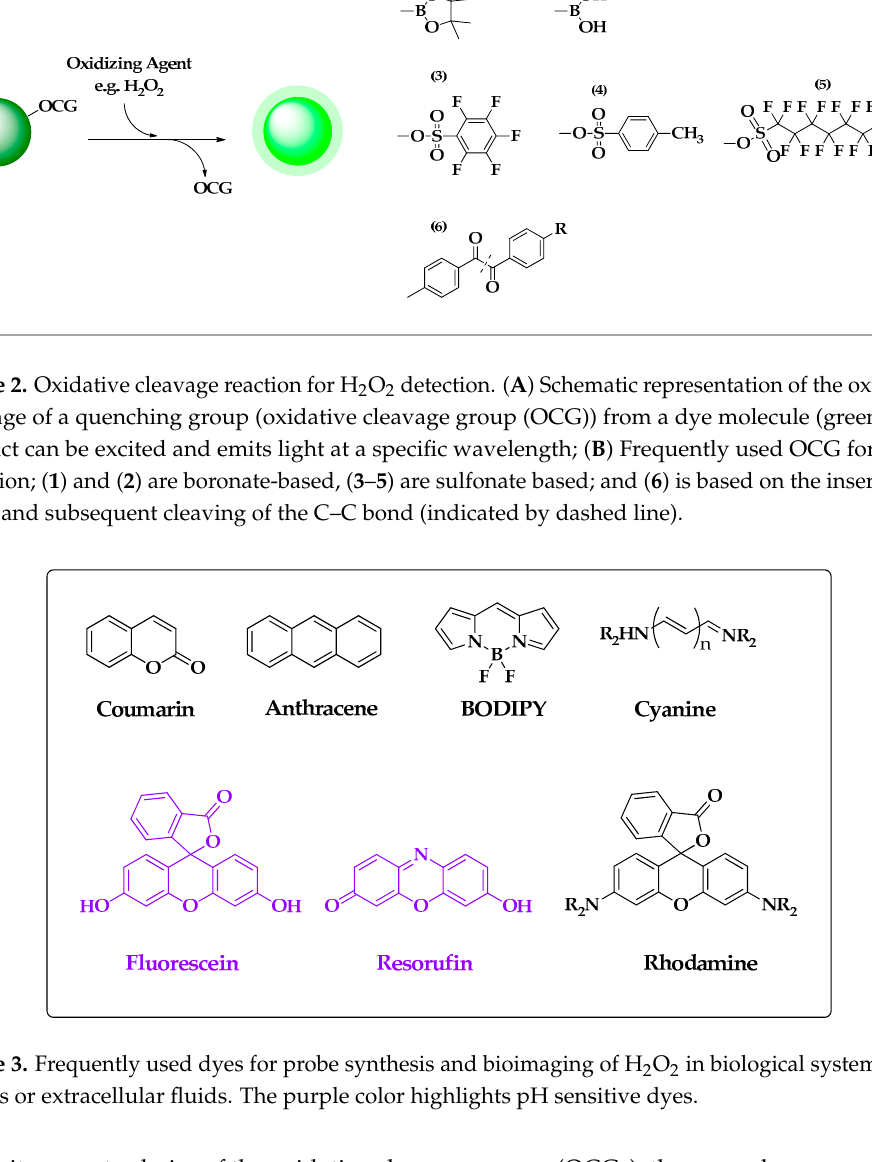
Figure 2. Oxidative cleavage reaction for H 2 O 2 detection. ( A ) Schematic representation of the oxidative cleavage of a quenching group (oxidative cleavage group (OCG)) from a dye molecule (green). The product can be excited and emits light at a specific wavelength; ( B ) Frequently used OCG for H 2 O 2 detection; ( 1 ) and ( 2 ) are boronate-based, ( 3 – 5 ) are sulfonate based; and ( 6 ) is based on the insertion of H 2 O 2 and subsequent cleaving of the C–C bond (indicated by dashed line).